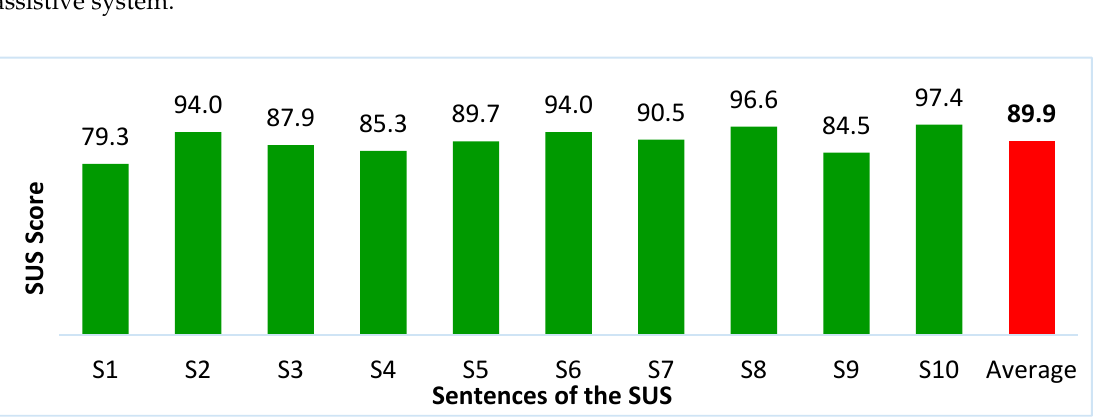
Figure 9. System Usability Scale (SUS) score of each of the ten items of the SUS.